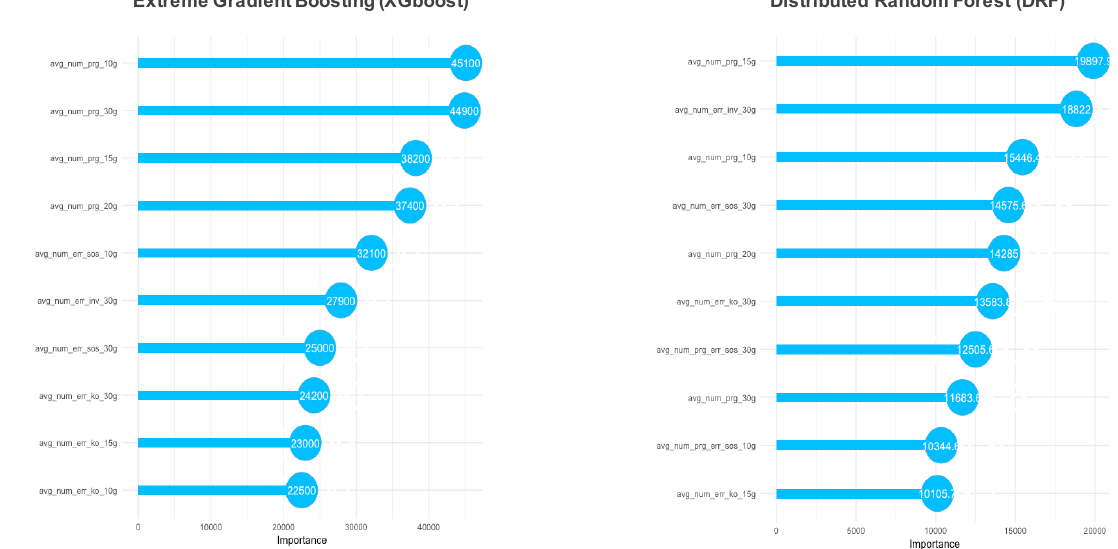
Figure A1. Variable importance of XGboost (left side) and DRF classifiers (right side). Horizontal plot shows the top 10 variables selected of the model to classify machine down against control